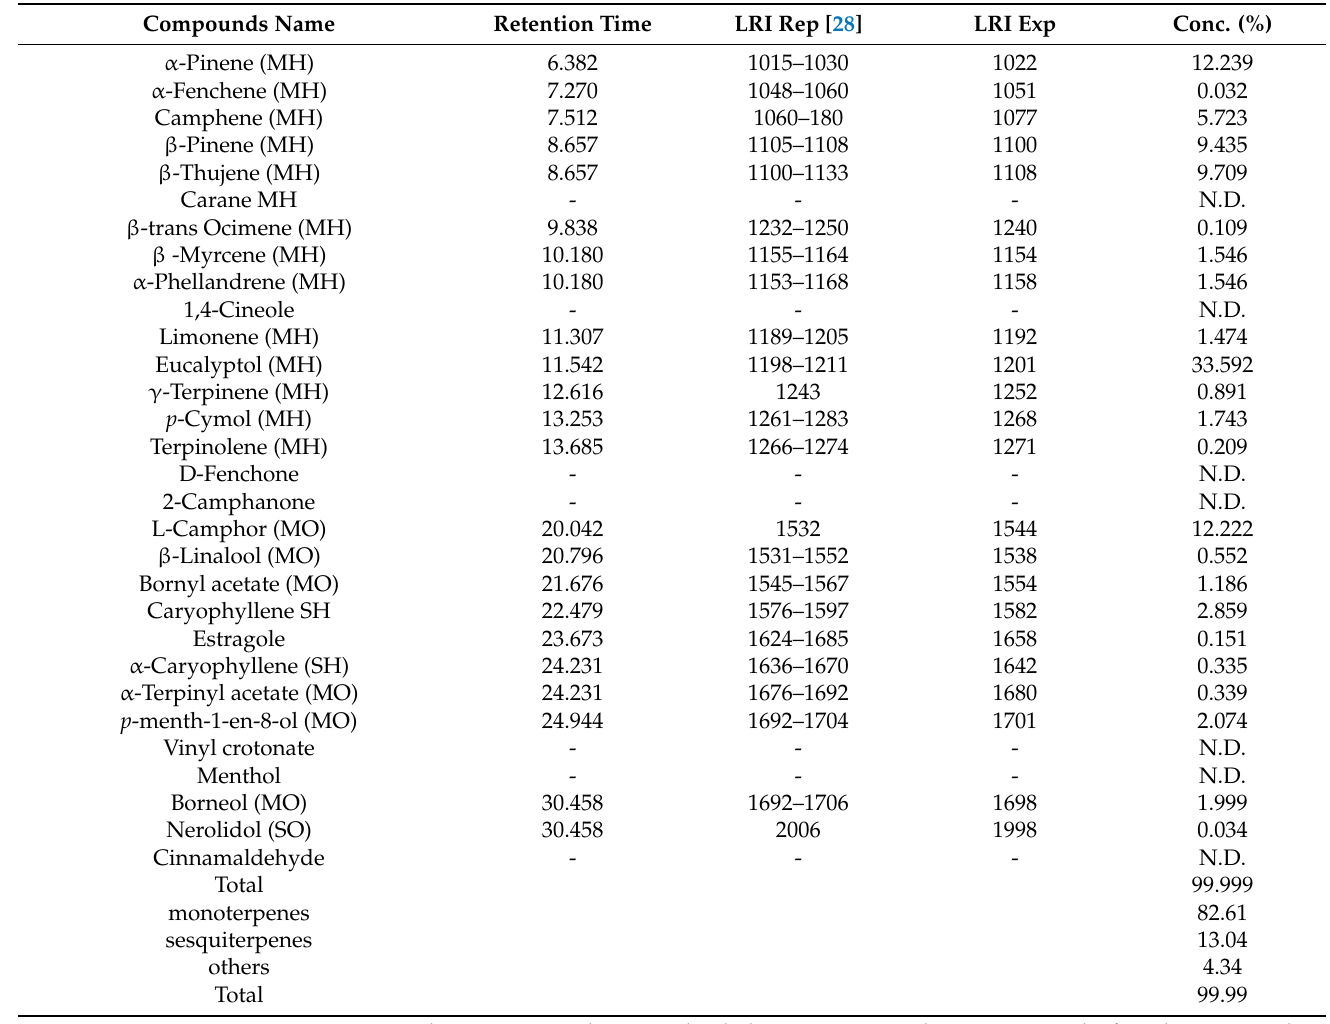
Table 2. The main phytochemical constituents of Rosmarinus Officinalis L. essential oil identified by GC-MS